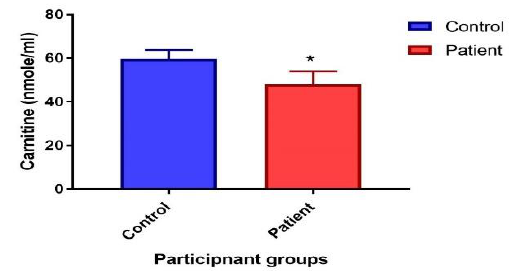
Figure 1. Serum Carnitine Level in Patient and